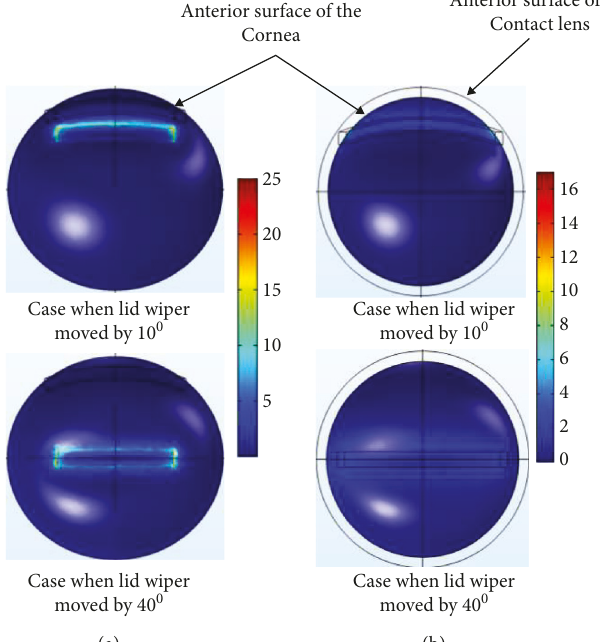
Figure 8: Contour plot of the von Mises stress in the cornea during blink without CL (a) and with CL (b) when the lid wiper is moved at superior (10 ° ) and central position (40 ° ) of the cornea (value of the legend shows von Mises stress; unit: kPa). The plots were exported as images from COMSOL Multiphysics v5.2 (https://www.comsol.com), and image collage was made using Microsoft PowerPoint 2019